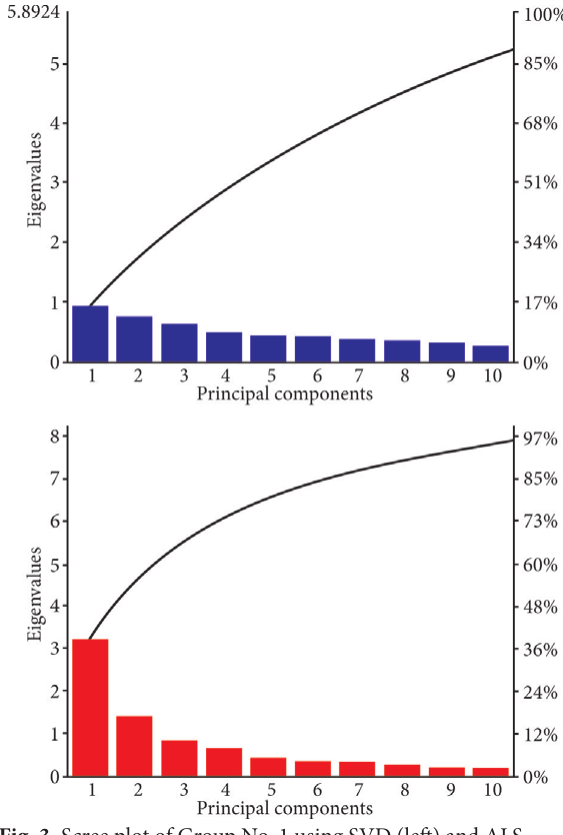
Fig. 3. Scree plot of Group No. 1 using SVD (left) and ALS (right) algorithm Table 5. Conclusion of principal components and retained variation from different algorithms